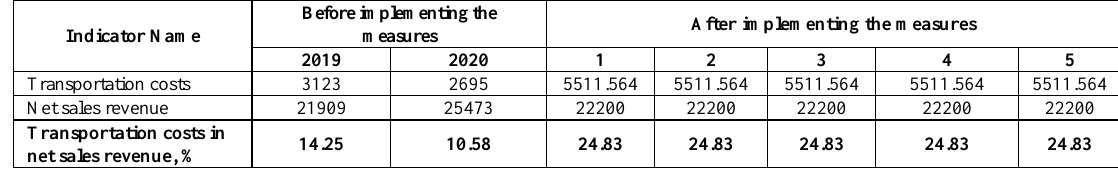
Table 6. Calculation of the proportion of transportation costs in net sales revenue,